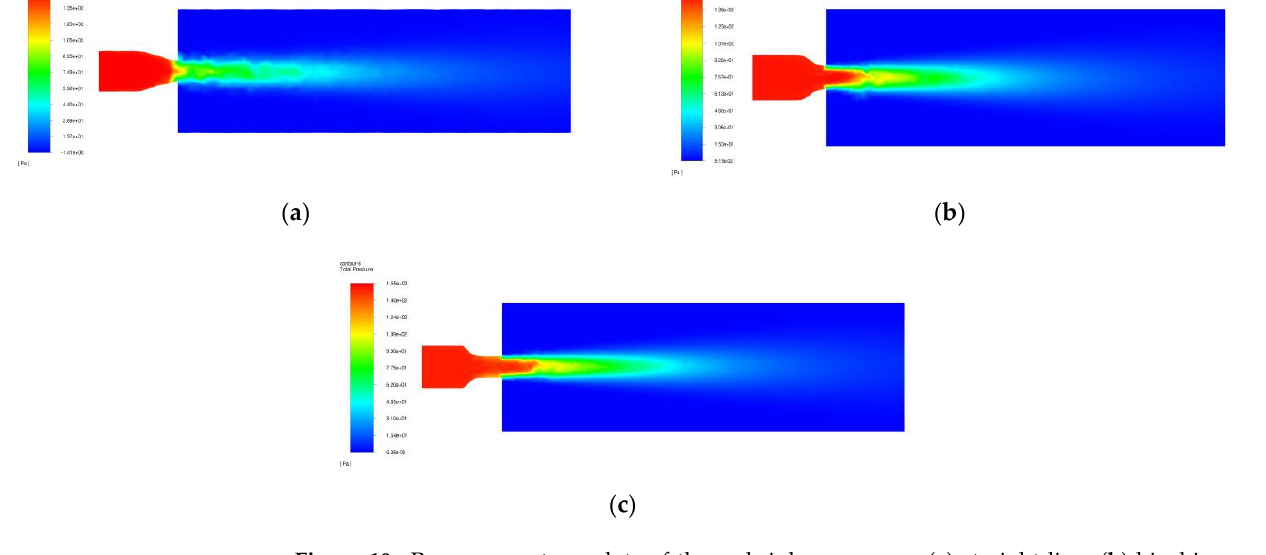
Figure 10. Pressure contour plots of three shrinkage curves: ( a ) straight line; ( b ) bicubic curve; ( c ) Witoszynski curve.